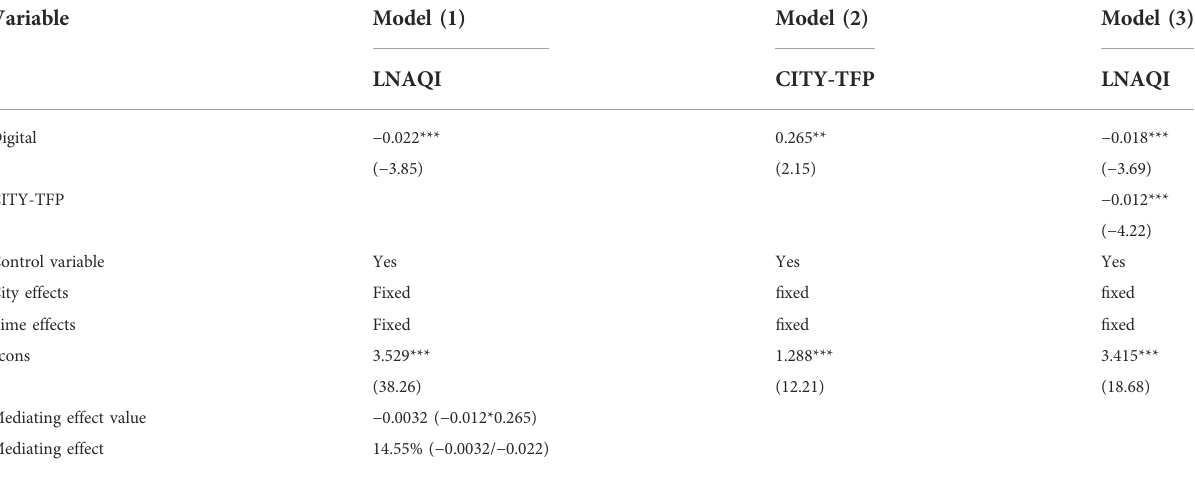
TABLE 4 Test results of the mediating effect of the